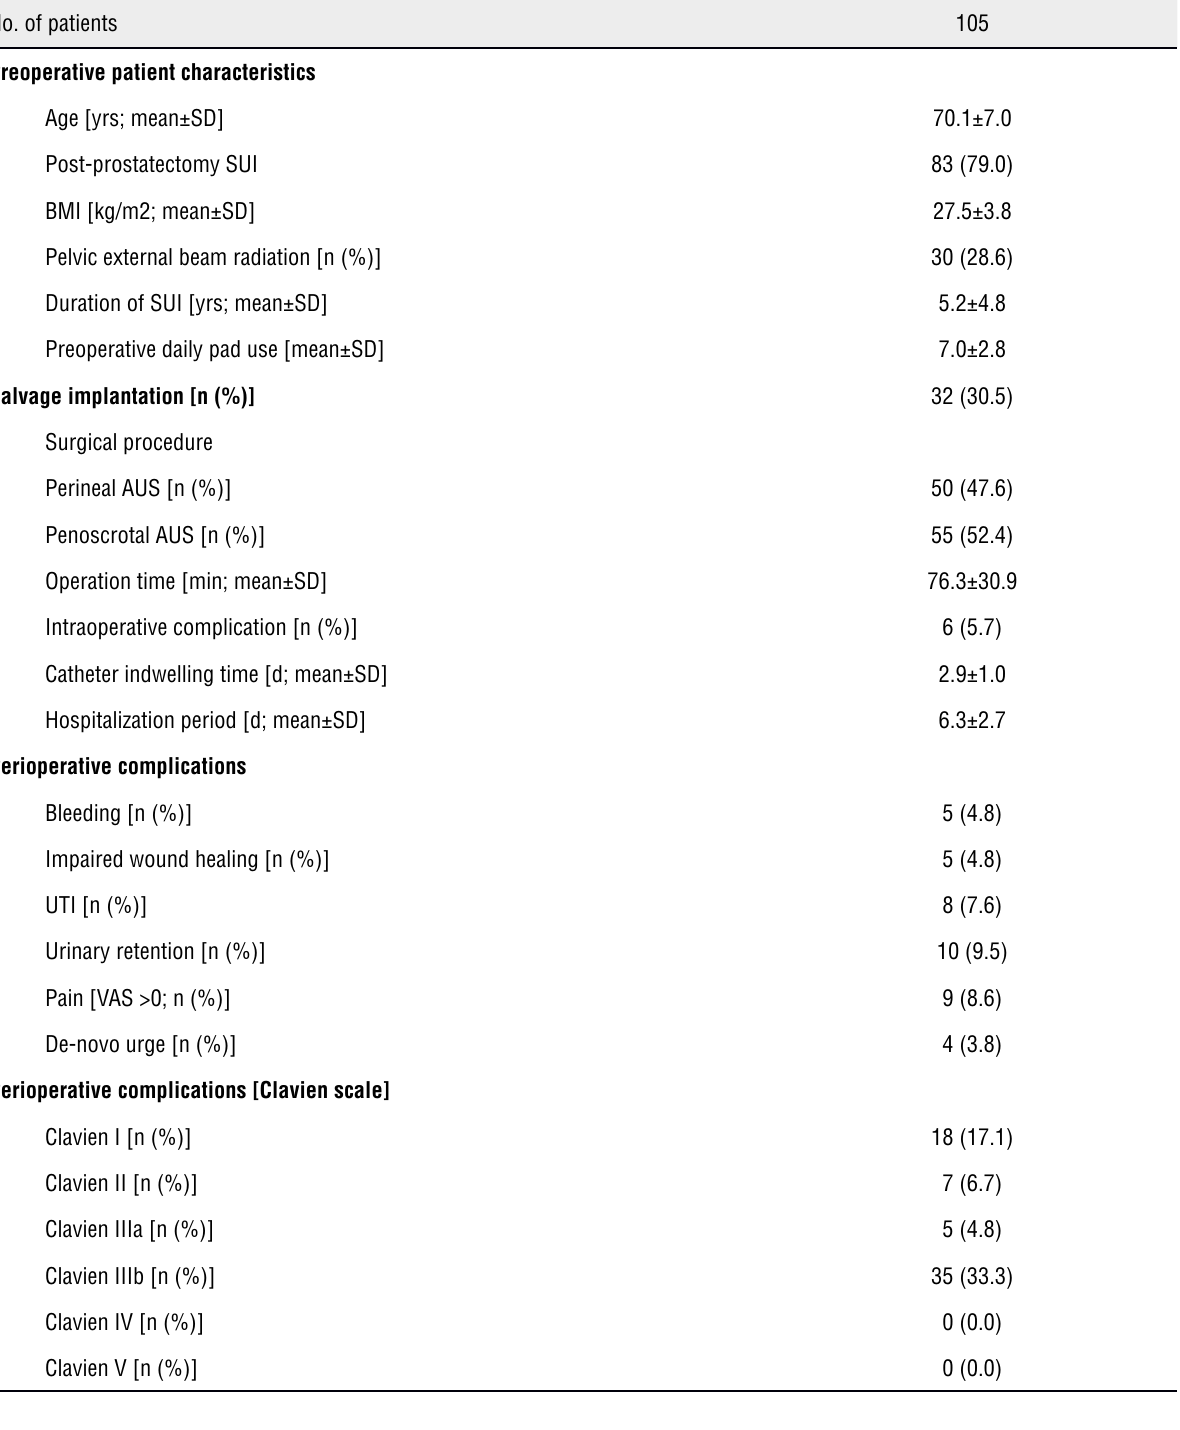
Table 1 - Patient characteristics of 105 patients that met the inclusion criteria and were included in the current